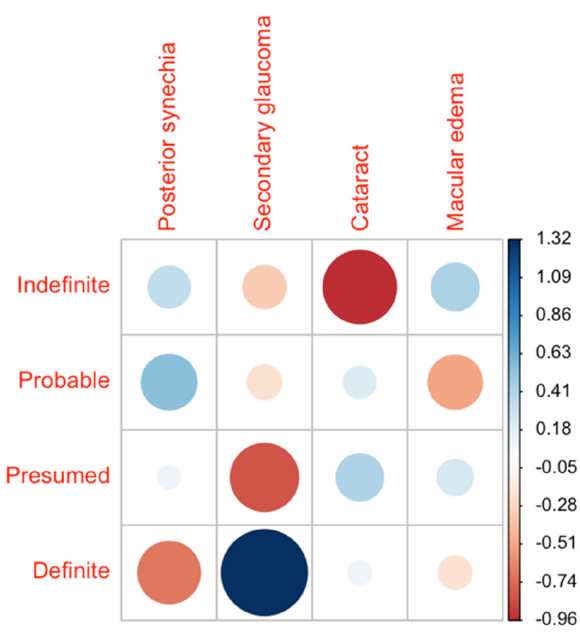
Figure 3. Distribution of the single ocular complications across the diagnostic groups. The data are presented as a correlation matrix. The blue color represents a higher-than-expected probability of occurrence, and red represents a lower probability. The larger the circles, the higher the deviation from the expected value given a homogeneous distribution across all groups.